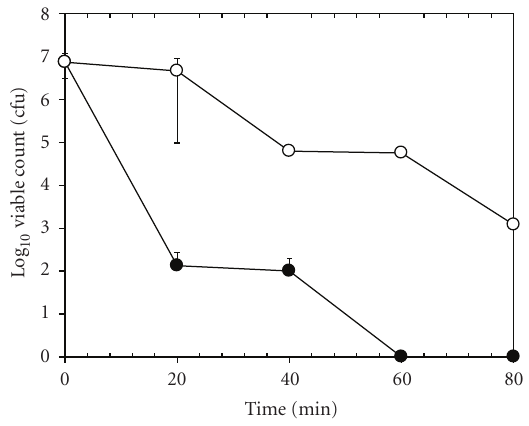
Figure 10: Killing of S. epidermidis on Ag over TiO 2 .